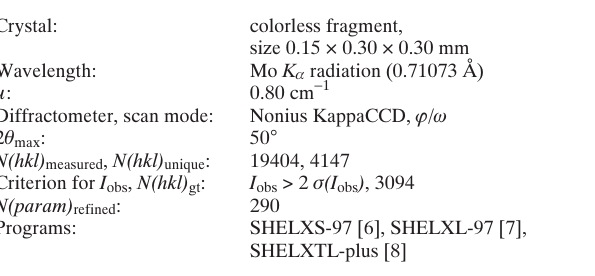
Table 1. Data collection and handling.